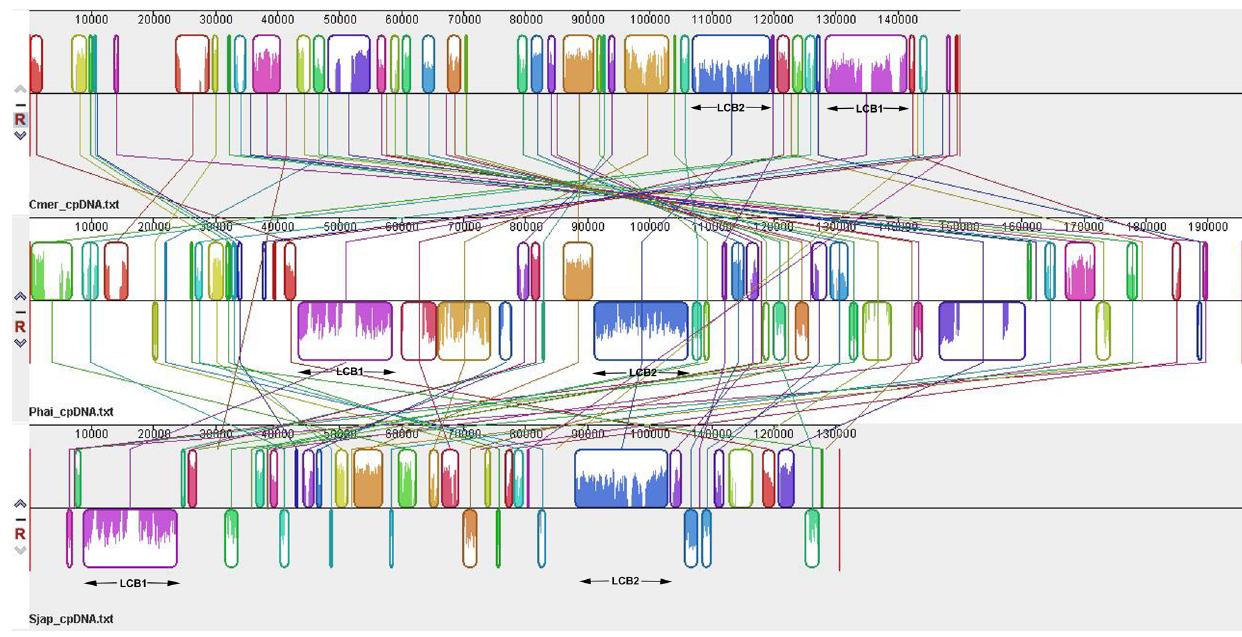
Figure 3. MAUVE genome comparison among C . merolae (upper), P . haitanensis (middle), and S . japonica (lower) plastid genomes. Locally collinear blocks (LCBs) identified by MAUVE are color-coded; links between LCBs are indicated by the thin colored lines. In the middle and lower portion of the Figure, P . haitanensis and S . japonica LCBs lying below the black line have an inverse orientation relative to C . merolae .